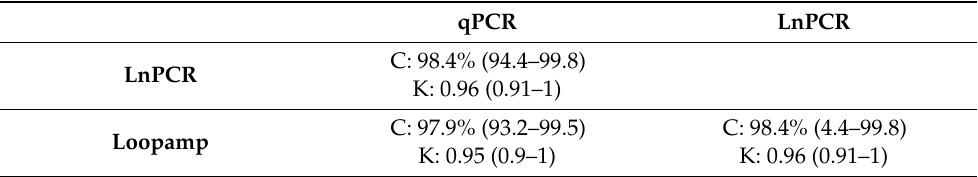
Table 3. Concordance of the Three Molecular Diagnostic Tests on Samples from CL and VL Suspected